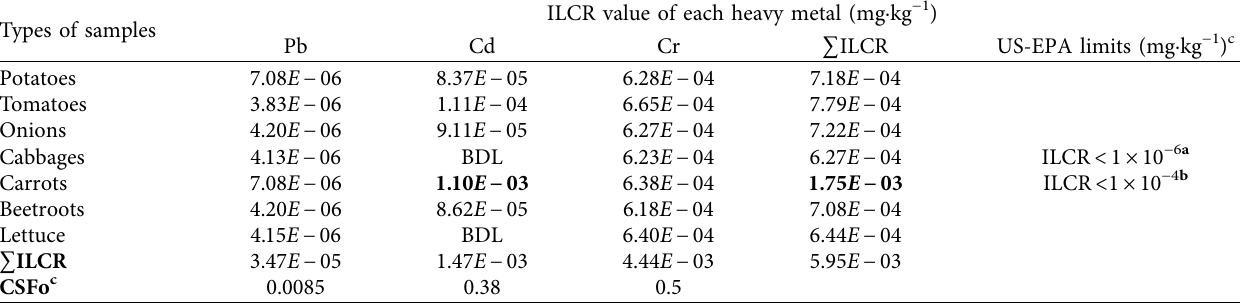
Table 9: ILCR and the cumulative cancer risk value ( 􏽐 ILCR) of heavy metals through the consumption of vegetables. Types of samples Potatoes Tomatoes Onions Carrots Beetroots